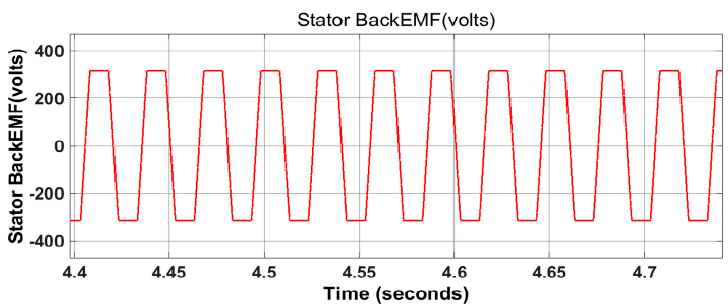
Figure 14. Expanded view of the stator back-EMF of the BLDC motor.